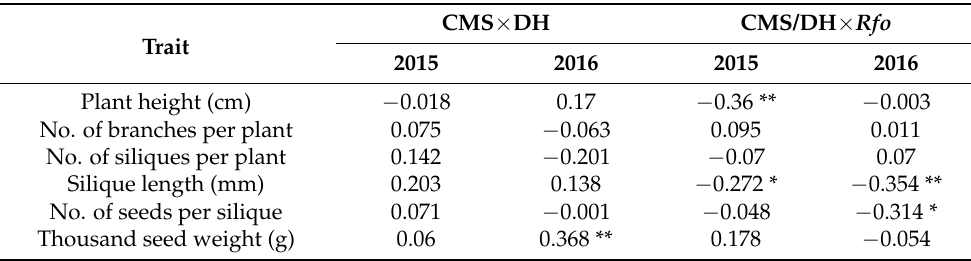
Table 3. Correlation coefficients between heterosis effect of CMS × DH and CMS/DH × Rfo hybrids and Mahalanobis distances of their parental